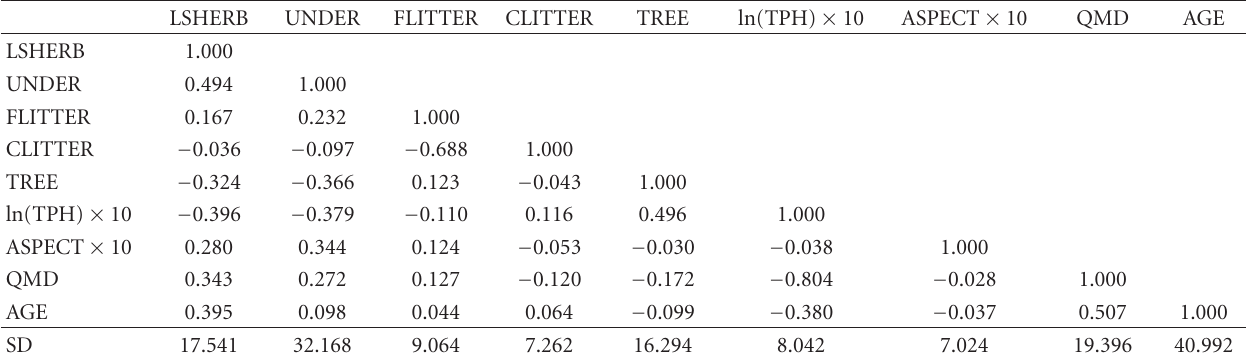
Table 2: Correlation matrix and standard deviation (SD) of the nine observed